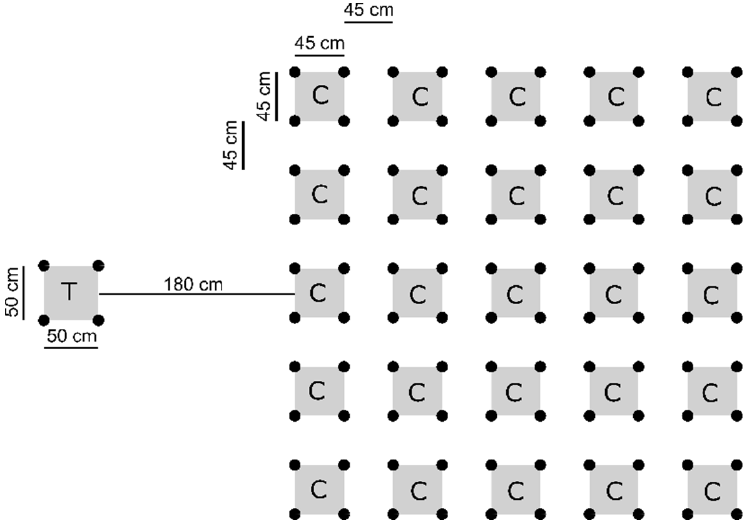
Figure 1. Disposition of squares for the Quadrato Motor Training (QMT) group training. The square reserved to the teacher is indicated with “T”, while the squares reserved to children are indicated with “C”.